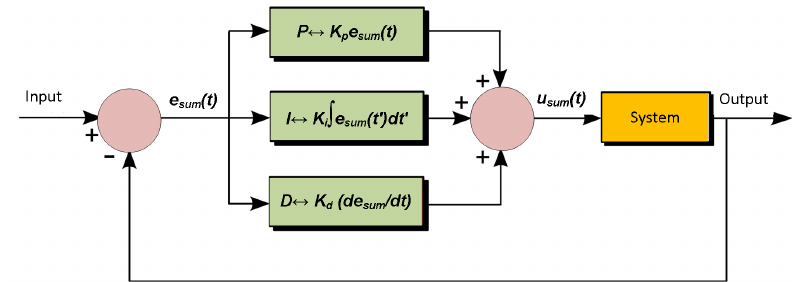
Figure 7. Working principle of a PID controller with feedback mechanism, indicating various components.